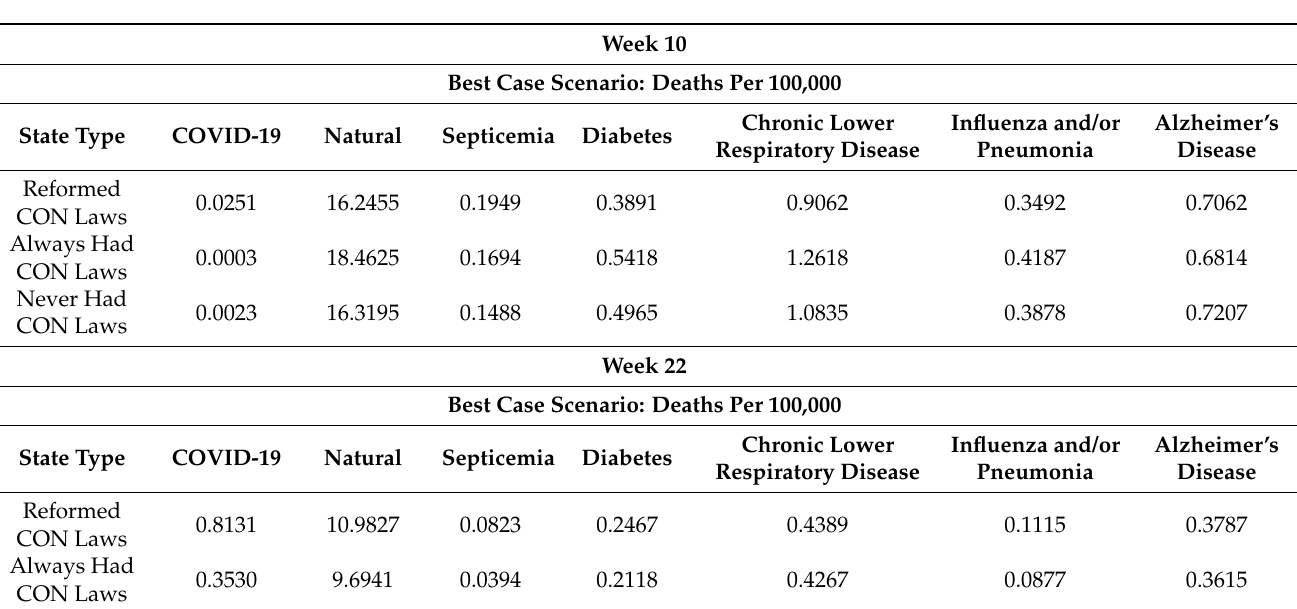
Table 1. Descriptive statistics of hospital fatalities for the week before the policy change and the last week of full data for all